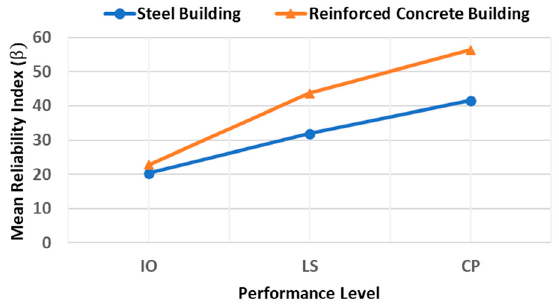
Figure 19. Mean reliability index for steel and reinforced concrete buildings located at Mexicali, Baja California (seismic zone D).